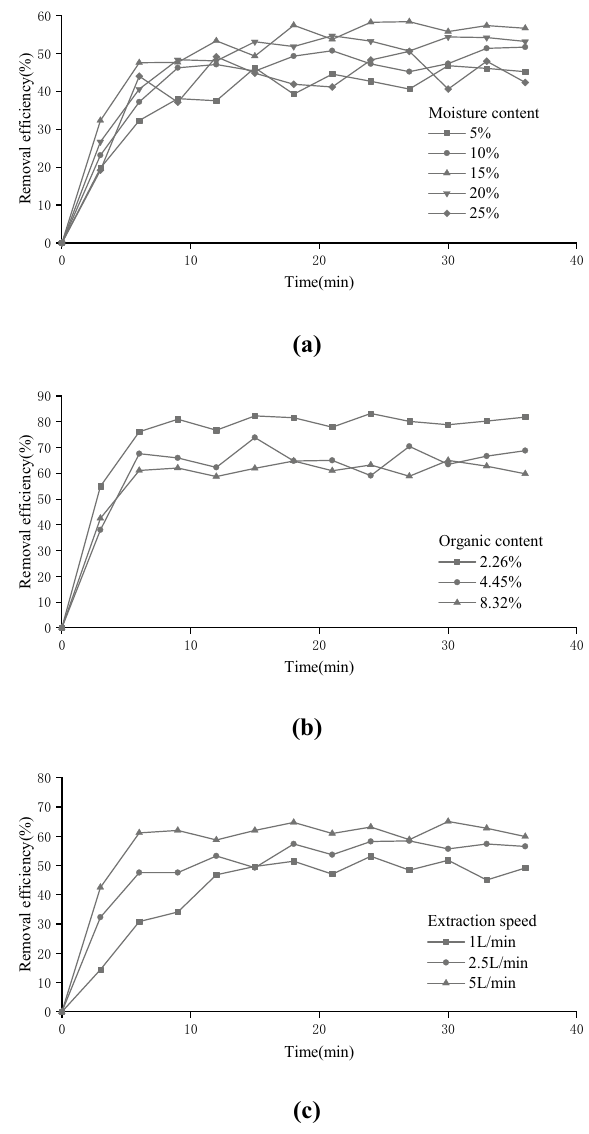
Figure 3. Factors affecting conventional SVE. ( a ) Moisture content, ( b ) Organic matter content, ( c ) Extraction